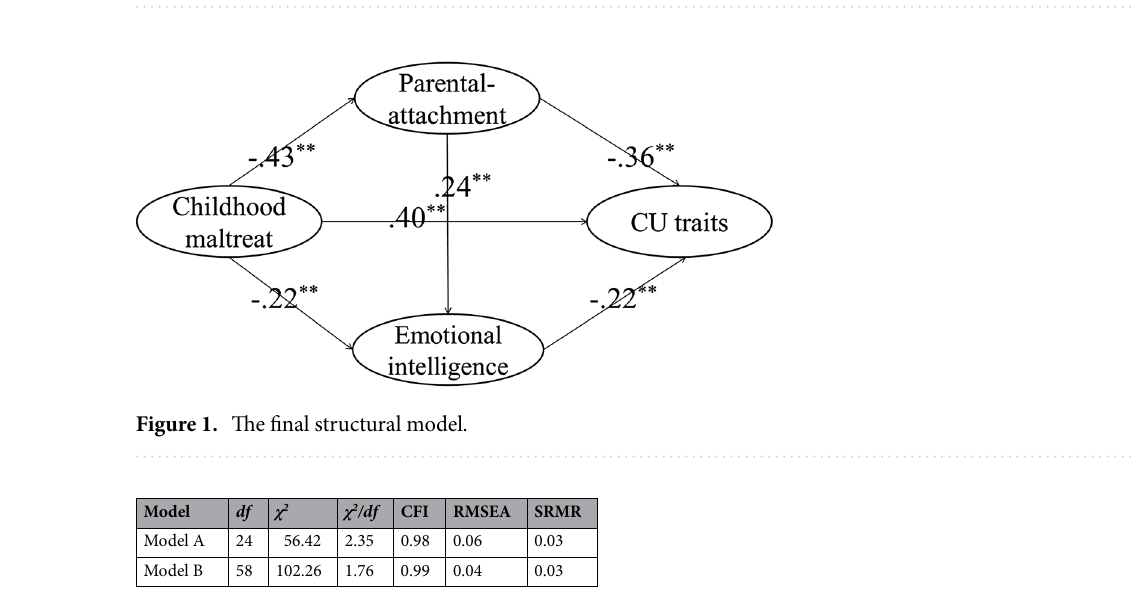
Table 1. Means, standard deviations, and correlations of the observed variables (n = 429). **p < 0.01.